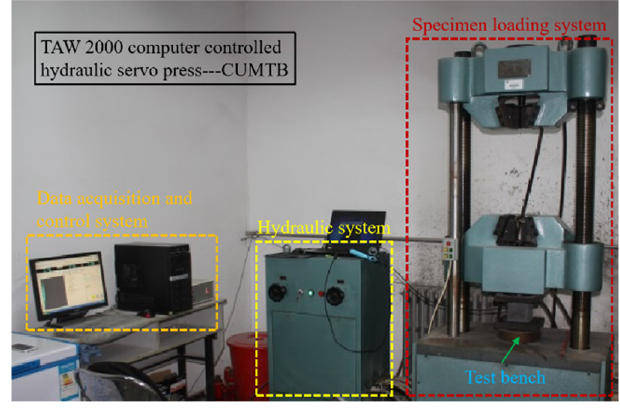
Figure 2. Experimental apparatus.